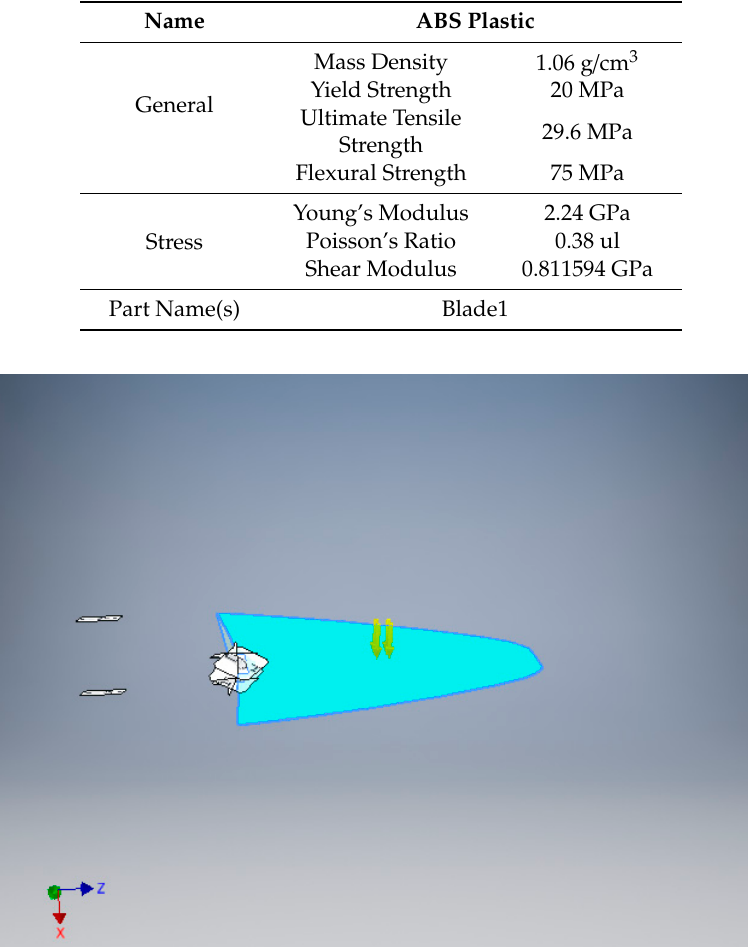
Table 1. The material properties of ABS plastic.